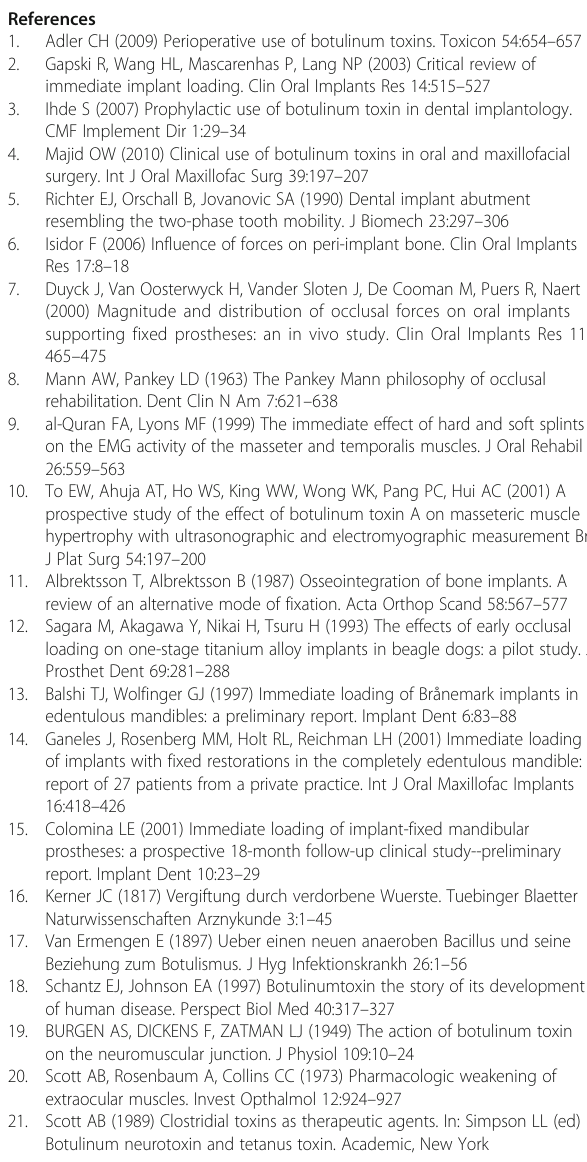
Table 2 Masticatory muscles and corresponding dose of botulinum toxin Muscle Origin Insertion Dose Number of injection Temporalis Temporal fossa Medial and anterior aspect of coronoid process of mandible Masseter Anterior two thirds of zygomatic arch and zygomatic Lateral surface of angle and lower ramus process of maxilla of mandible Medial pterygoid Deep head: medial side of lateral pterygoid plate and Medial aspect of angle of fossa between medial and lateral plates. Superficial head: tuberosity of maxilla and pyramidal process of palatine bone